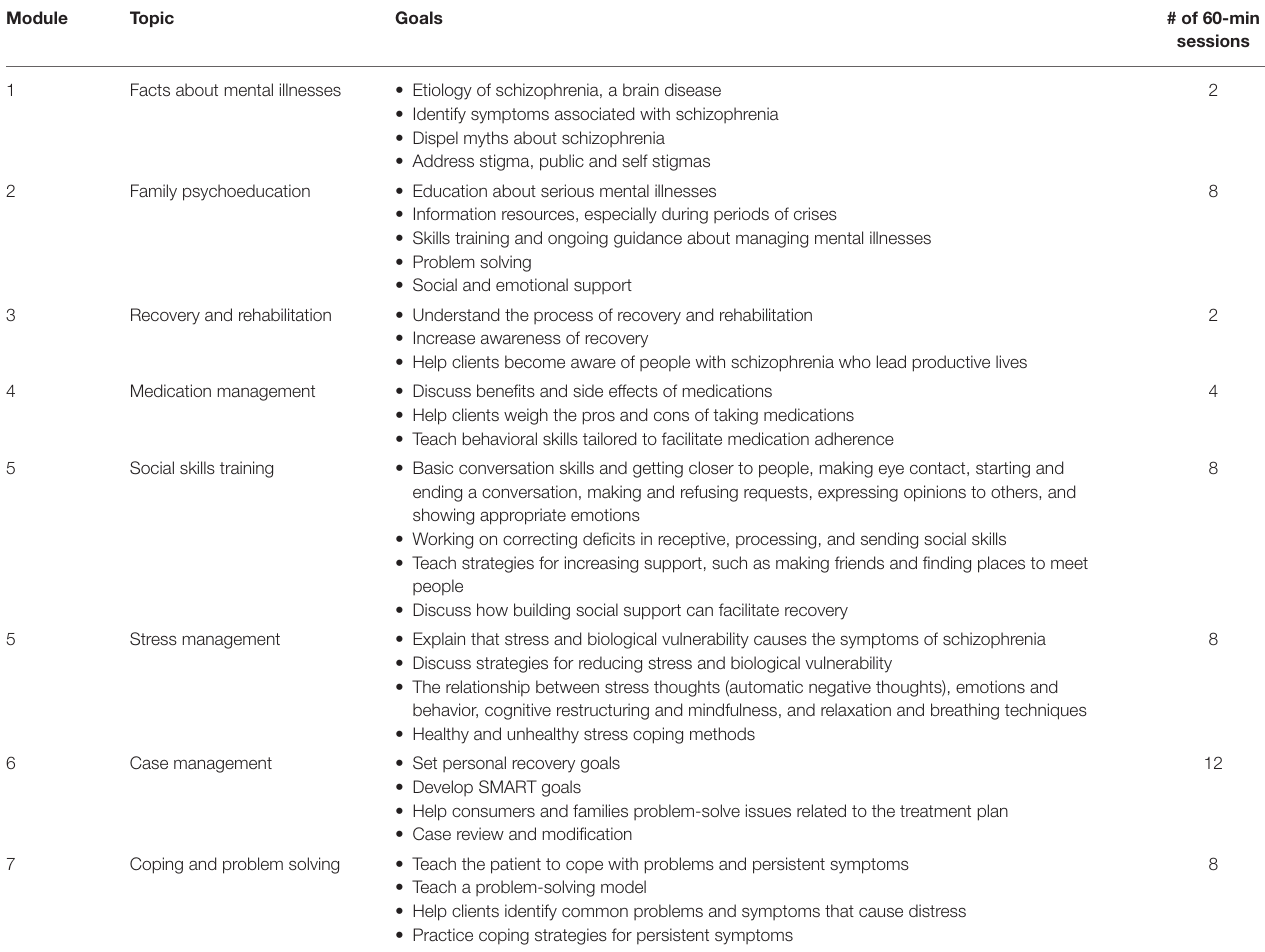
TABLE 1 | Overview of the topics for the LPD community psychiatric rehabilitation program modules. Module